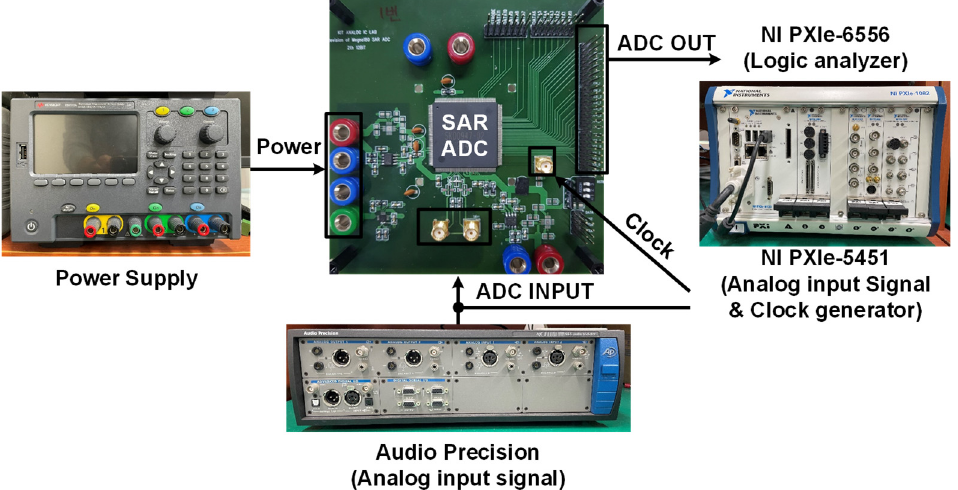
Figure 7. Chip photograph of implemented 11-bit SAR ADC.